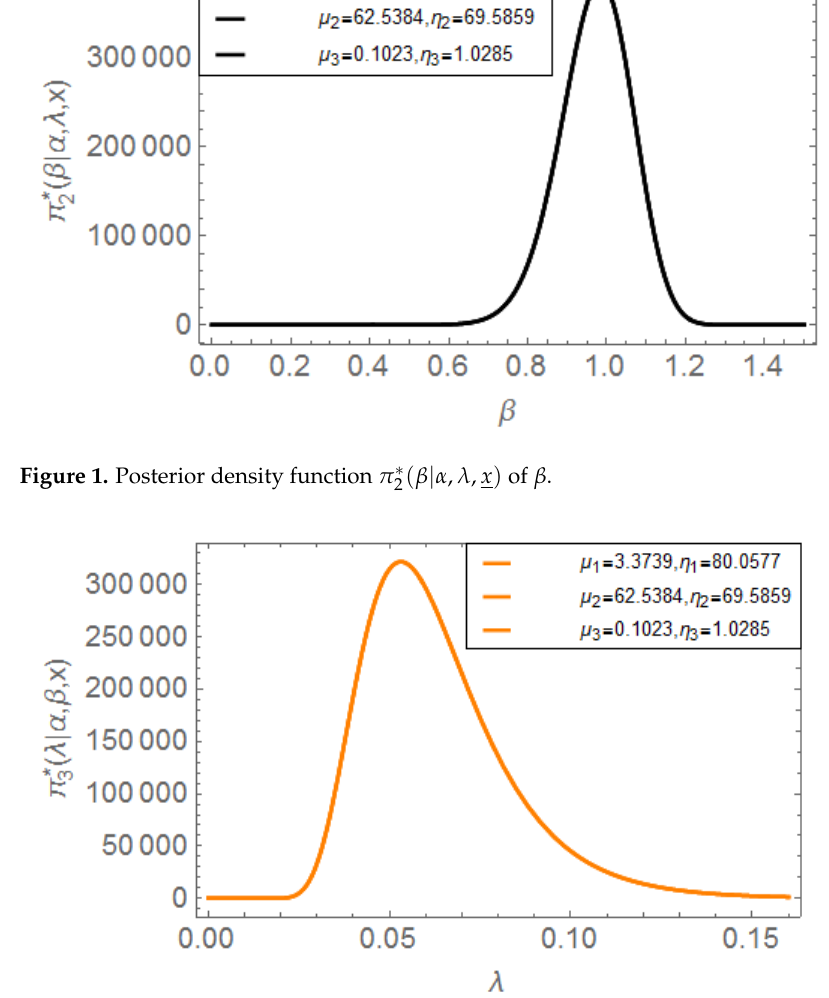
Figure 2. Posterior density function π ∗